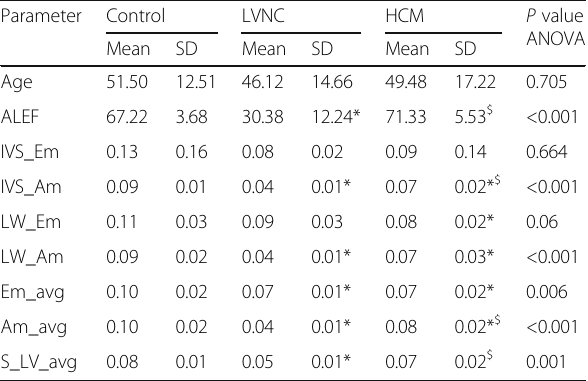
Table 1 Baseline demographic and echocardiographic findings in patients with LVNC, HCM, and controls Parameter